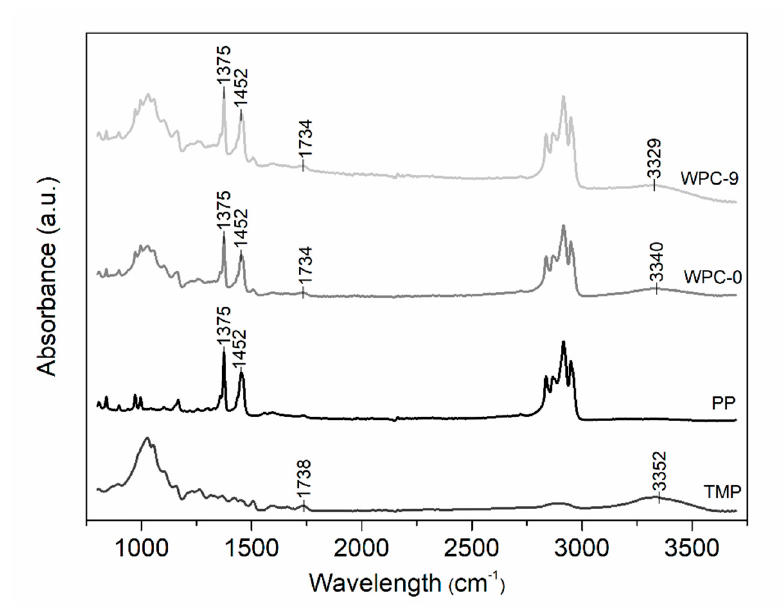
Figure 11. Fourier transform infrared (FTIR) spectra of TMP, PP, WPC-0, and WPC-9.